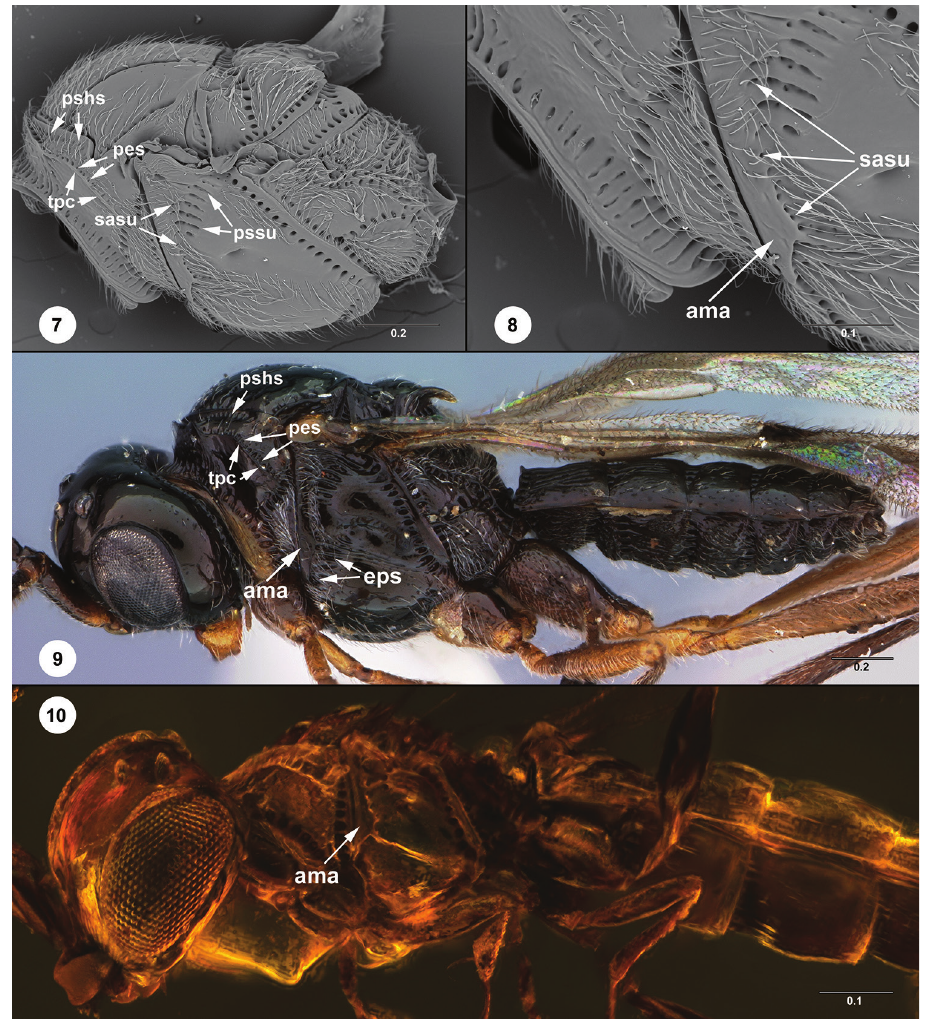
gracilis , male (OSUC 163002), pronotum and mesopleuron, posterolateral view 9 Archaeoteleia araucana , male paratype (OSUC 163001), head, mesosoma, metasoma, lateral view 10 Archaeoteleia astropulvis , head, mesosoma, metasoma, lateral view. Scale bars in